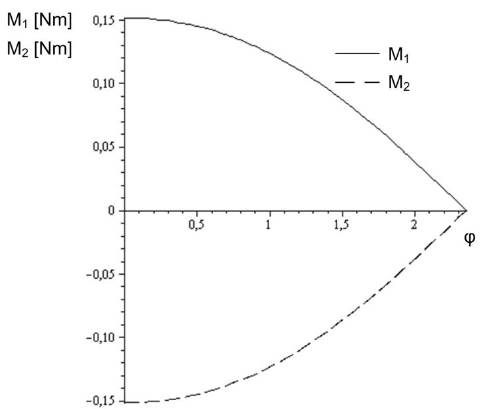
Figure 19: Plots of M 1 ( φ ) and M 2 ( φ ) for Example